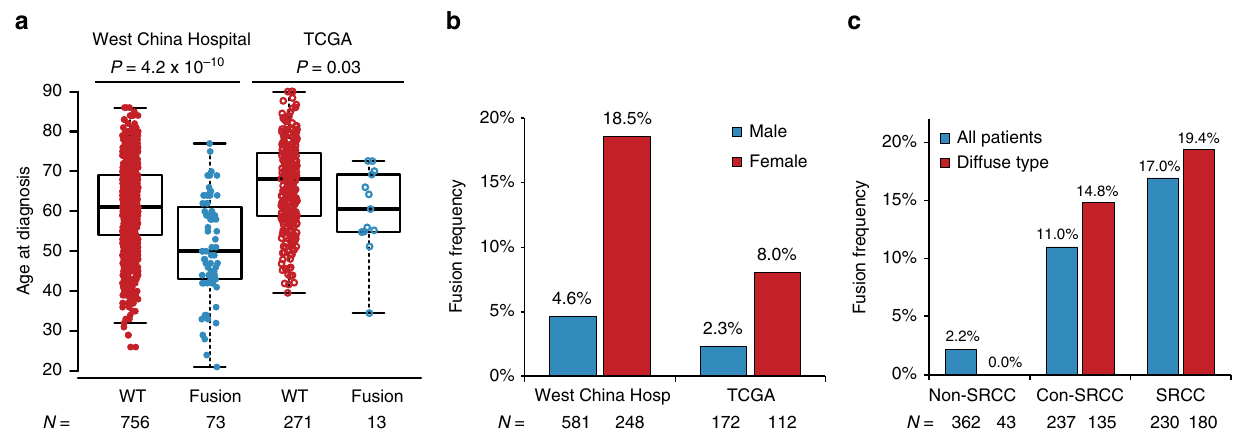
Fig. 4 Clinical characteristics of patient with CLDN18 - ARHGAP26/6 . 829 Patients (combining 32 patients for whole-genome sequencing and 797 patients for validations) with distinct clinical features in terms of age, gender, and signet-ring cell content were illustrated in a – c , respectively. P value was estimated by using logistic regression, and the center values represent median age; WT, wildtype. Each box includes data between the 25th and 75th percentiles, with the horizontal line indicating the median. Whiskers indicate the maximal and minimal observations that are within 1.5 times the length of the box